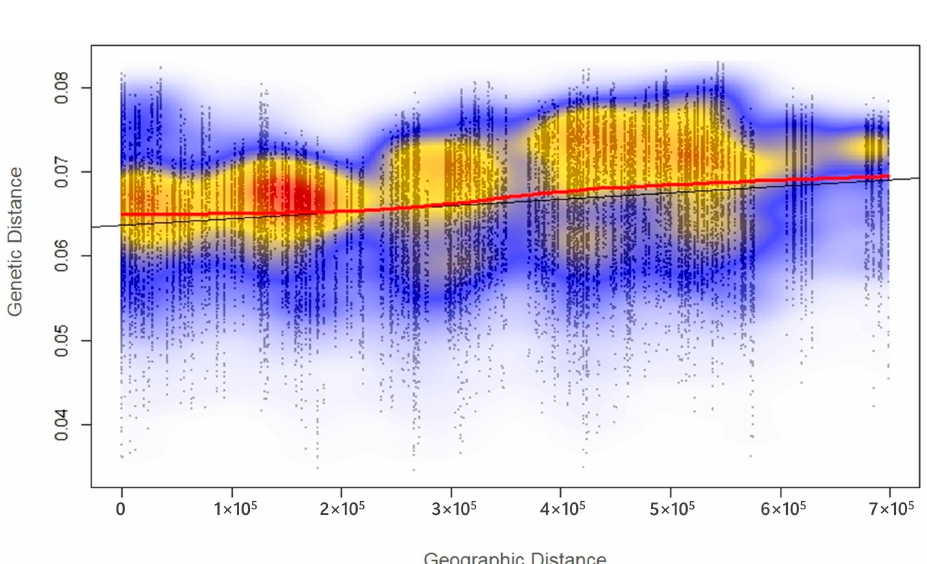
Figure 11. Graph showing linear relationship between genetic and geographic distances based on the Mantel test and all 25,143 SNPs ( r = 0.206, p = 0.001). The different colors represent different densities of genetic and geographic distance correlation values (red—high density, blue—low density), the smoothed local mean (red line) and the regression (black line).